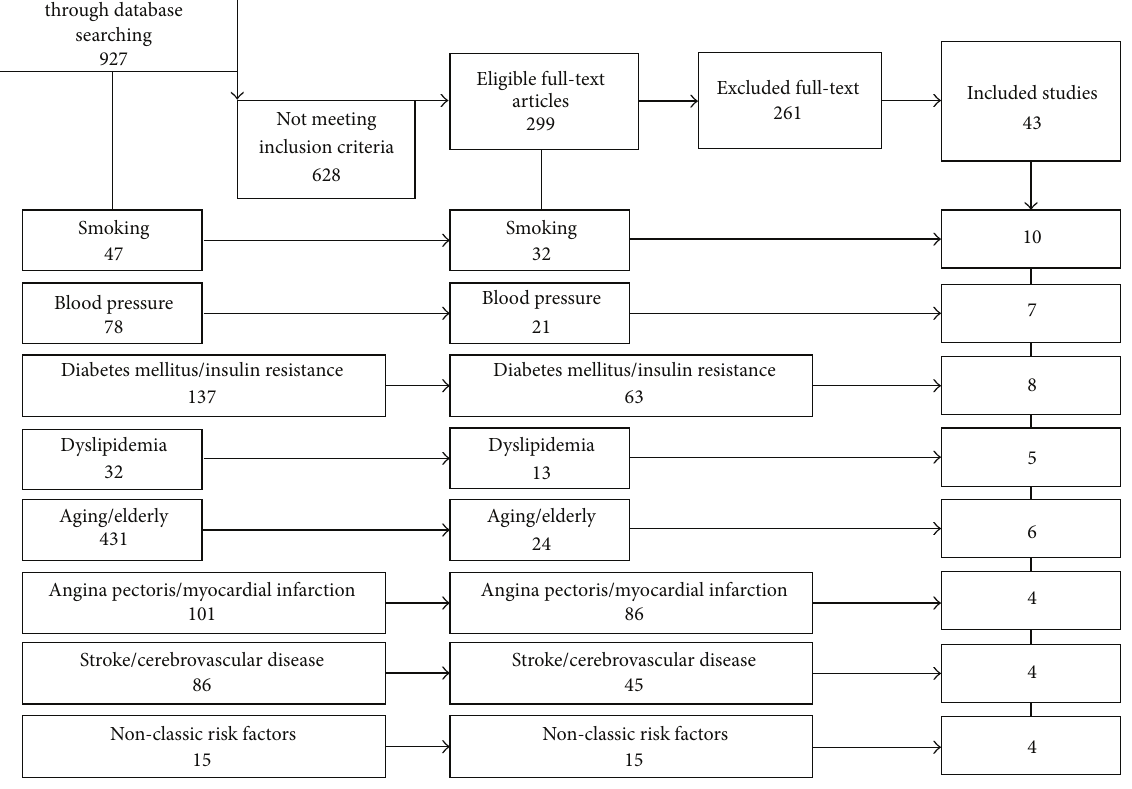
Figure 1: Flow diagram for patients